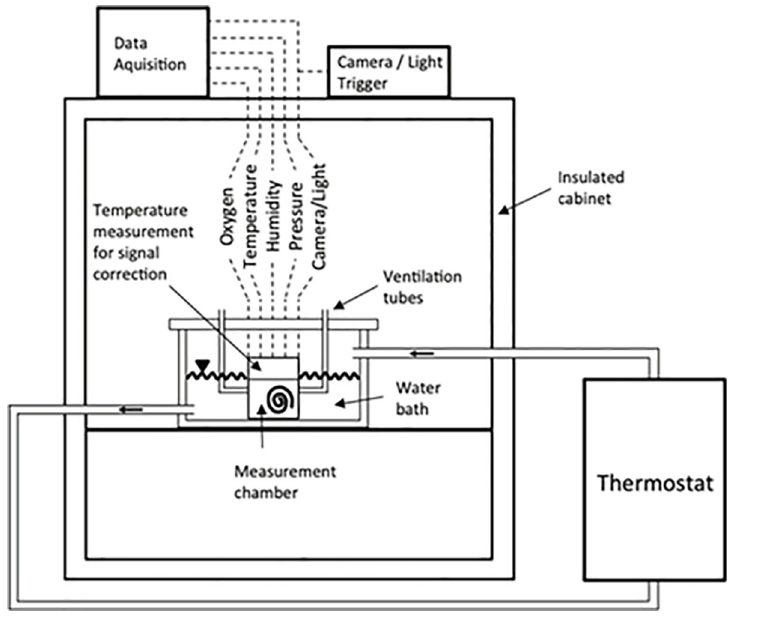
Fig 1. Schematic depiction of the camera-equipped micro respirometry